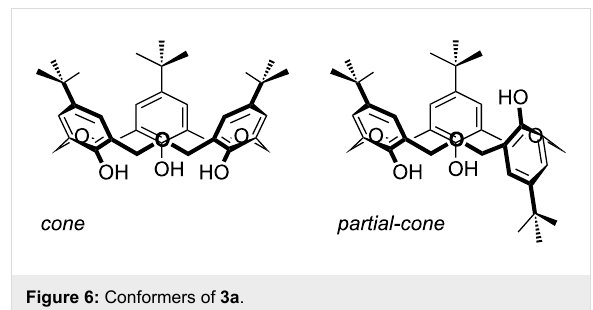
Figure 6: Conformers of 3a